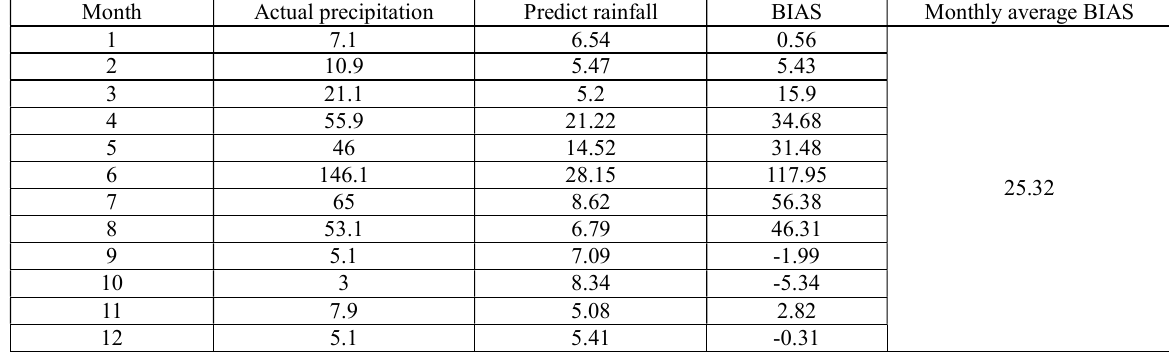
Table 2. Monthly maximum precipitation and forecast precipitation in